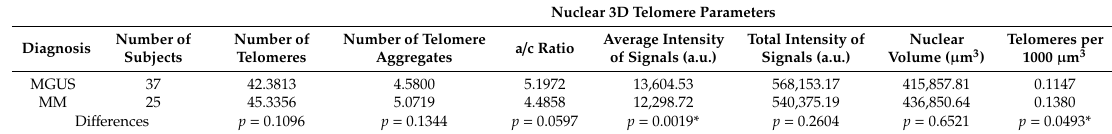
Table 2. Summary of parameters of 3D nuclear telomere architecture, according to monoclonal gammopathy of undetermined significance (MGUS) or multiple myeloma (MM) diagnosis (significant results are marked with an asterisk; a.u.—arbitrary units). p -value of < 0.05 was considered